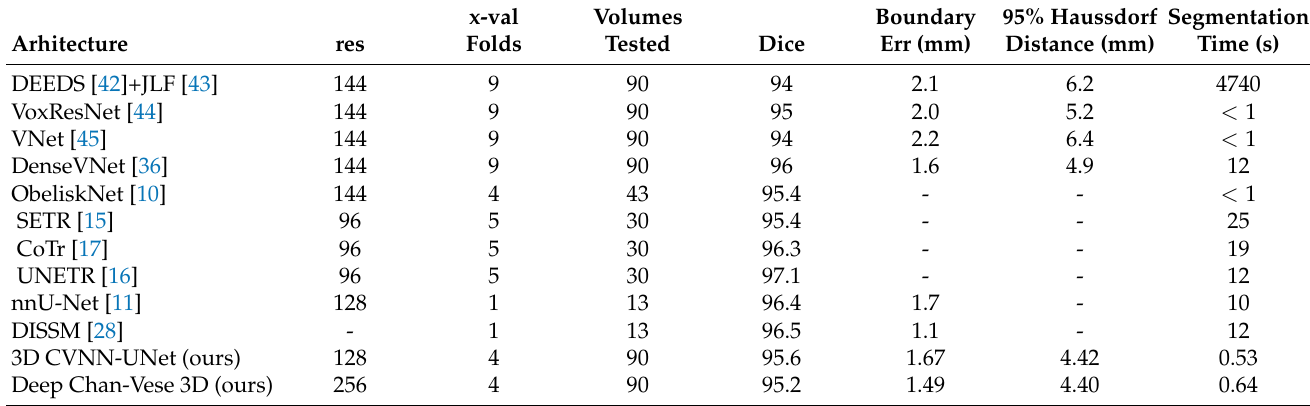
Table 2. Comparison with the state of the art methods for liver segmentation on the 90-volume multi-organ dataset [36] and other datasets. The 9-fold cross-validation results are taken from [36] , the 5-fold results are from [16] and the 1-fold from